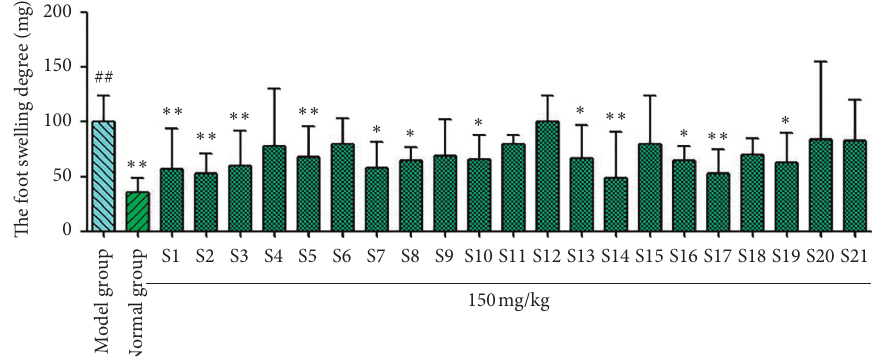
Figure 7: Results of foot swelling of Glycyrrhiza uralensis Fisch. flavonoids from 21 producing areas. The result represents mean ± S.D. Note. Compared with the normal group, ## P < 0 . 01 is a very significant difference. Compared with the model group, ∗ P < 0 . 05 was considered to be significant; ∗ ∗ P < 0 . 01, and there was a significant difference ( n � 10).